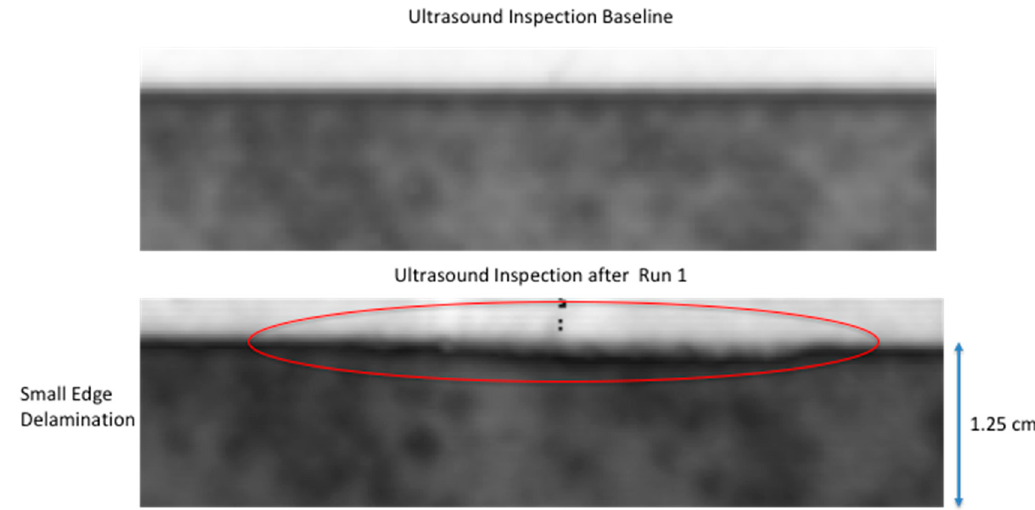
Figure 4. Processed thermal inspection images for a single quasi-static load run 1.